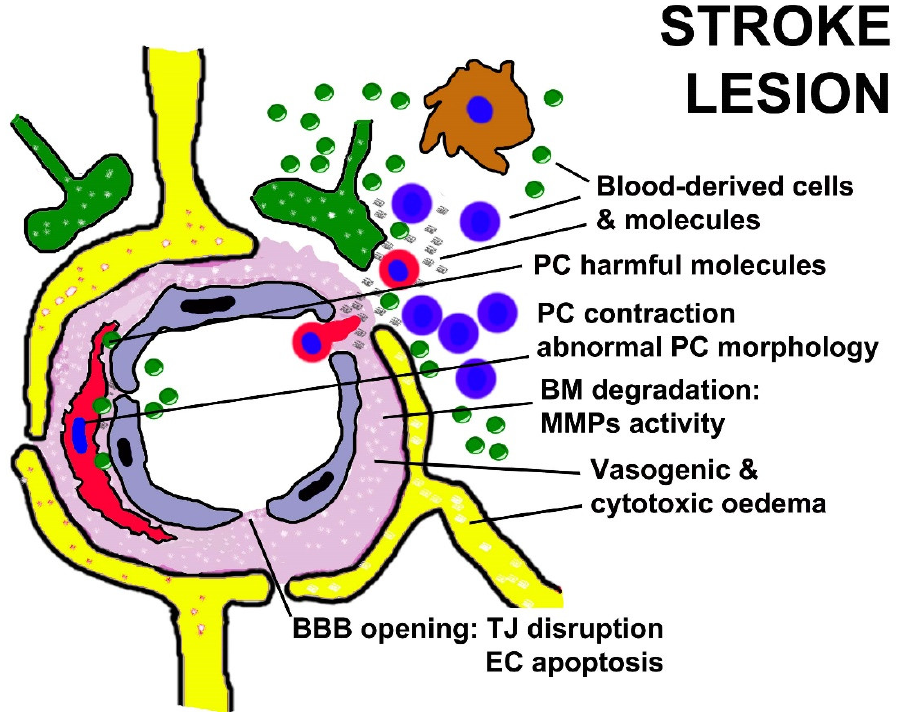
Figure 4. A schematic depiction of NVU components in a stroke lesion dominated by BBB leakiness, vasogenic swelling of BM, cytotoxic oedema, a PC hypercontracted state, astrocyte endfeet detachment from PCs, and completely disrupted NVU interactions: the TJ proteins claudin-5 and occludin are damaged and EC apoptosis is frequently observed; the BM is degraded by MMPs, mainly released by leukocytes infiltrating vessel BM and PCs enwrapping altered endothelial cells; large amounts of pro-inflammatory mediators and fibrin(ogen) derive from the blood stream, but additional harmful inflammatory molecules are released by PCs. Table 2. Summary of PC dysfunction during clinical and experimental CNS conditions. Disease